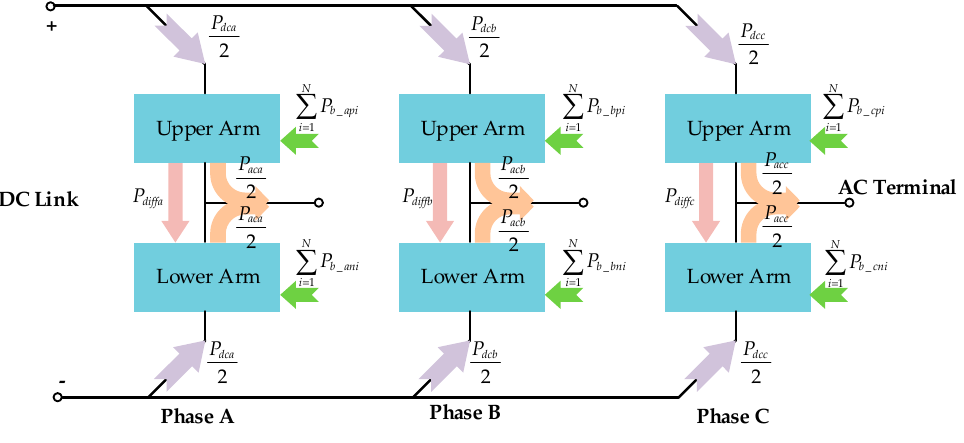
Figure 3. Power flows of the MMC-BESS.